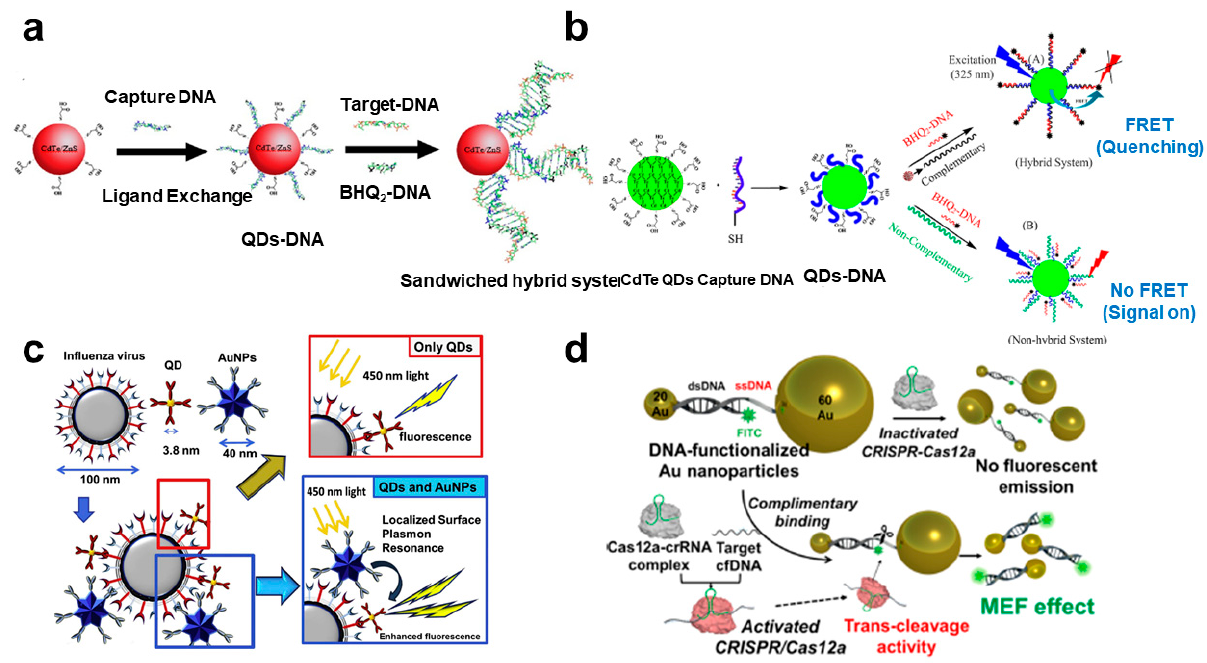
Figure 1. Viral DNA-target fluorescence biosensors using plasmonic nanomaterials: ( a ) Schematic diagram of the QDs-DNA-based target DNA detection system. This figure is reproduced from [48] (© 2022 Elsevier B.V.); ( b ) Schematic diagram of the FRET-based SARS-CoV2-DNA detection. This